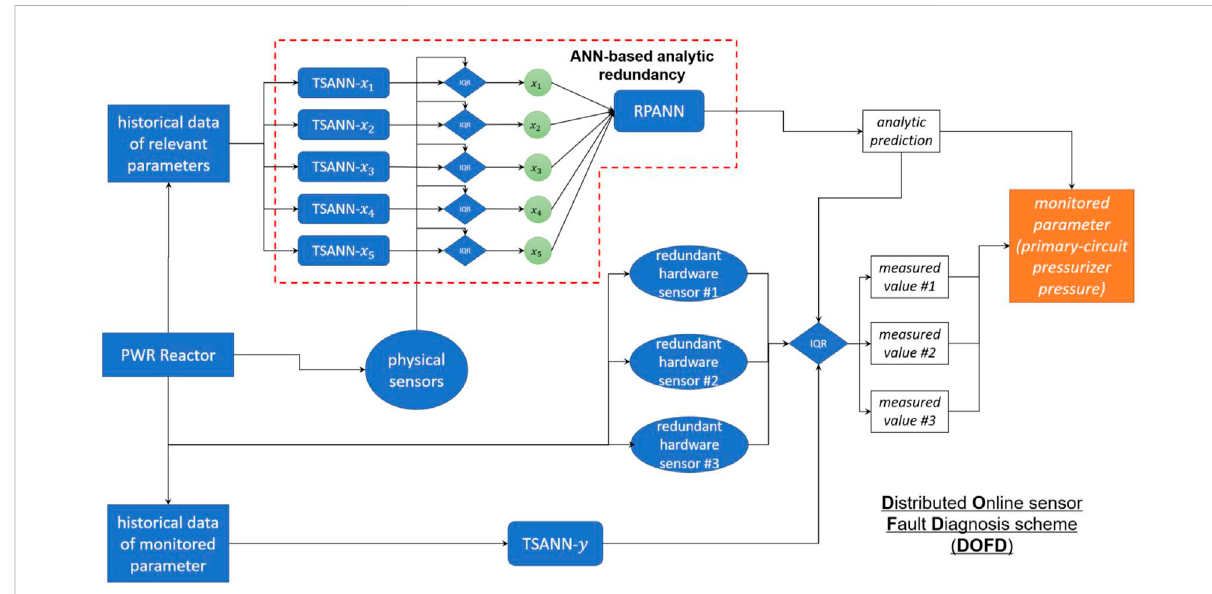
TSANNs as self-checking modules, builds up an “ ANN-based analytic redundancy ” , as marked with a dotted red line in Figure 7. With this software redundancy, an analytic “ measurement ” of the pressure in the primary-circuit pressurizer can be